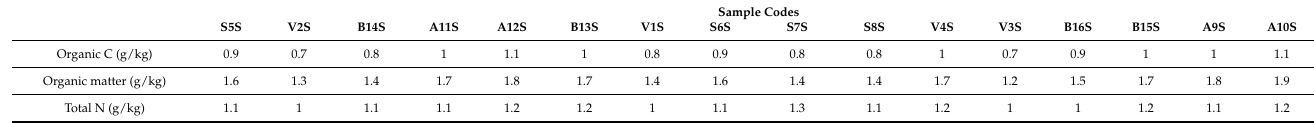
Table 1. Results of the soil physicochemical analysis. Sample codes refer to the name of the sam- ples reported in Table 1. For each soil parcel analysis was performed on bulk soil (“S”) samples. Exc,